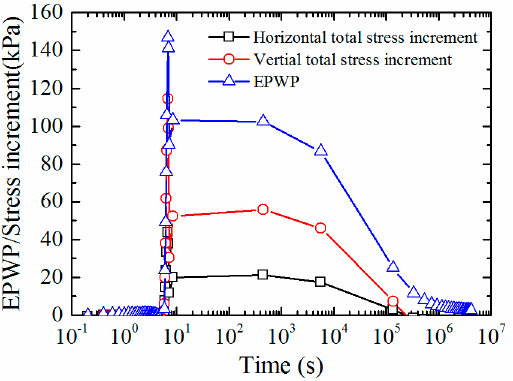
Figure 18. Time histories of the EPWP and total stress increment of soil around the